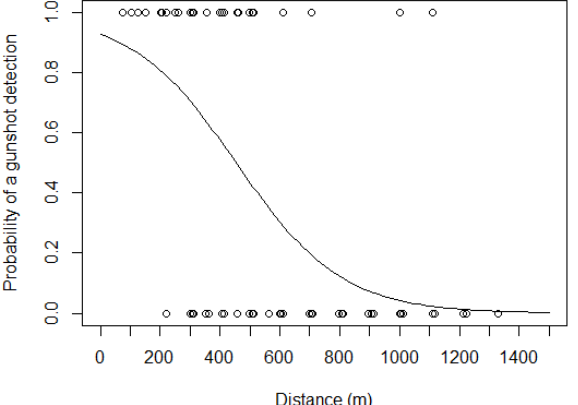
Figure 6. Fitted logistic regression of the probability of a gunshot being detected using the DTD 1.5.6 gunshot detection algorithm with threshold 0.4, plotted as a function of the acoustic sensor’s (SWIFT rugged model) distance to the gunshot.